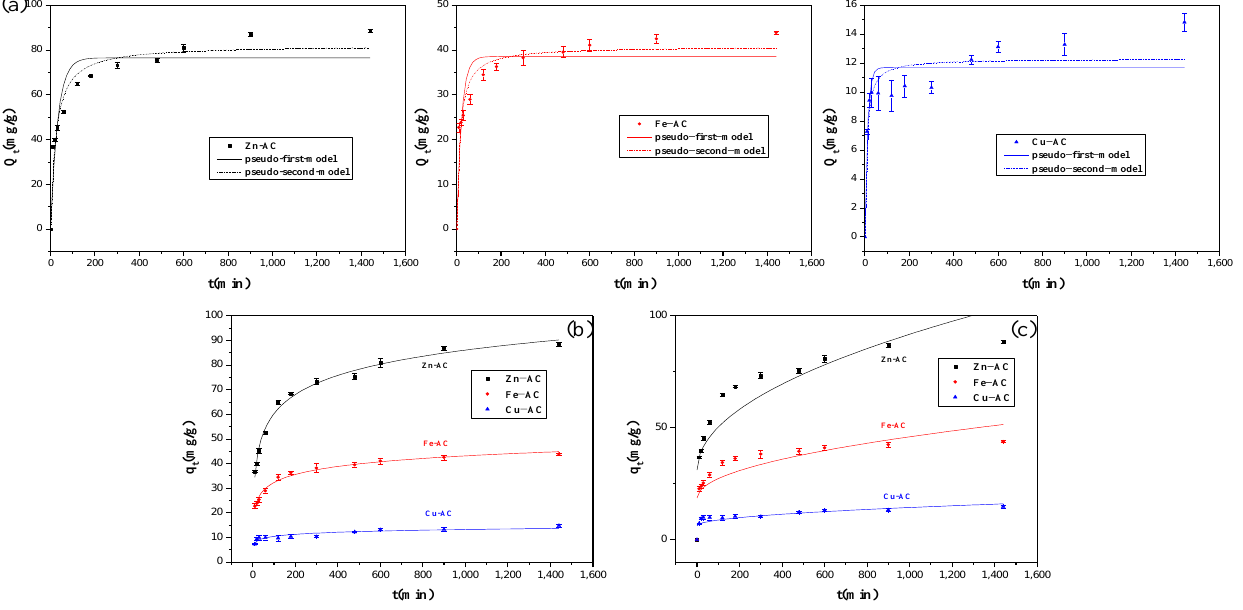
Figure 9. The adsorption kinetic curves of Cr(VI) onto the samples: ( a ) PFO and PSO; ( b ) Elovich; ( c ) intra − particle diffusion.